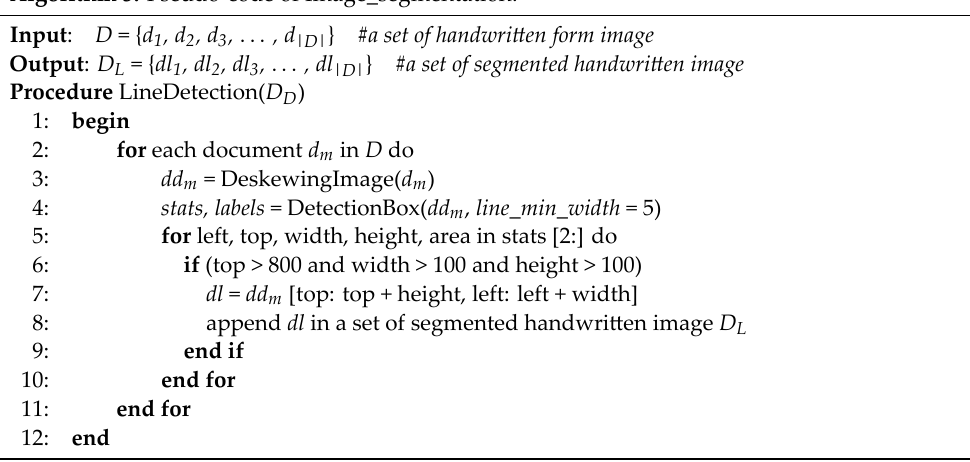
Algorithm 3: Pseudo‑code of Image_segmentation.